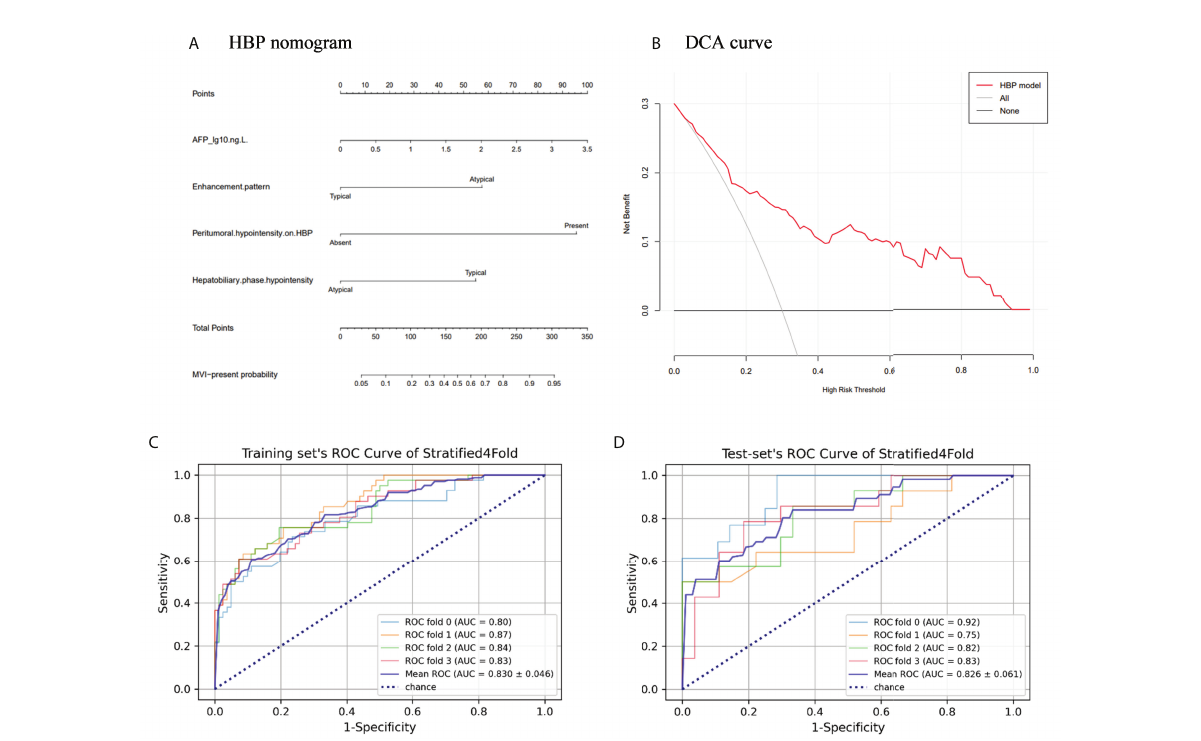
FIGURE 5 The nomogram and receiver operating characteristic curves for predicting MVI: (A) HBP model visualized by nomograms; (B) Decision curve analysis (DCA) of HBP model; (C) Training set ’ s receiver operating characteristic (ROC) curves of strati fi ed 4-fold; (D) Test set ’ s ROC curves of strati fi ed 4-fold.